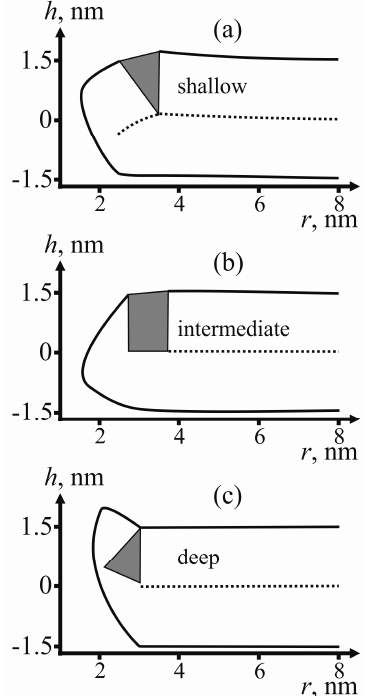
Figure 5. Calculated shape of the membranes for different depths of insertion of fusion peptides. ( a ) Shallow insertion; ( b ) intermediate insertion; ( c ) deep insertion. Fusion peptide is shown in gray, the dotted line is the position of the inter-monolayer surface.